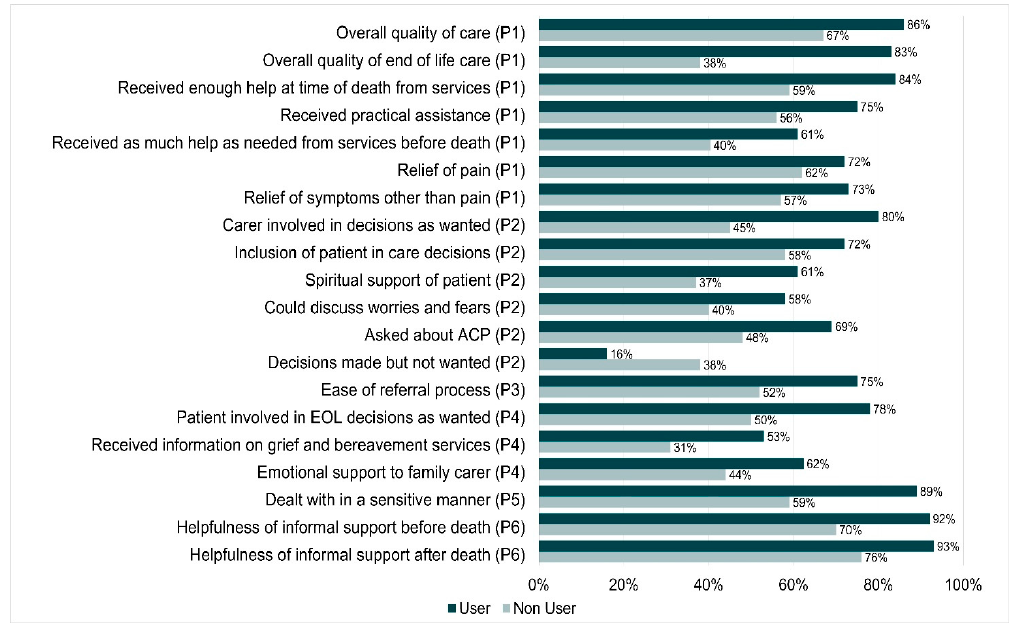
Figure 1. Differences in care between users and non-users of palliative care services (with EOL strategy priority number).